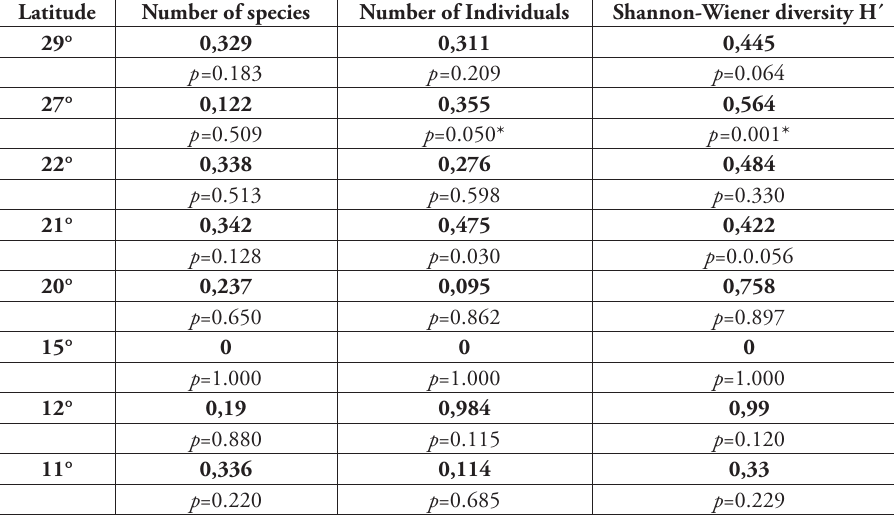
table 6. Regression correlation (r) analysis of fish community pattern vs. soft coral (simple regression); mean fish abundance (N), species richness (number of species) and Shannon-Wiener Index (H`) at reefs at various latitudes along the Red Sea and Gulf of Aden. * if p <0.05 significant